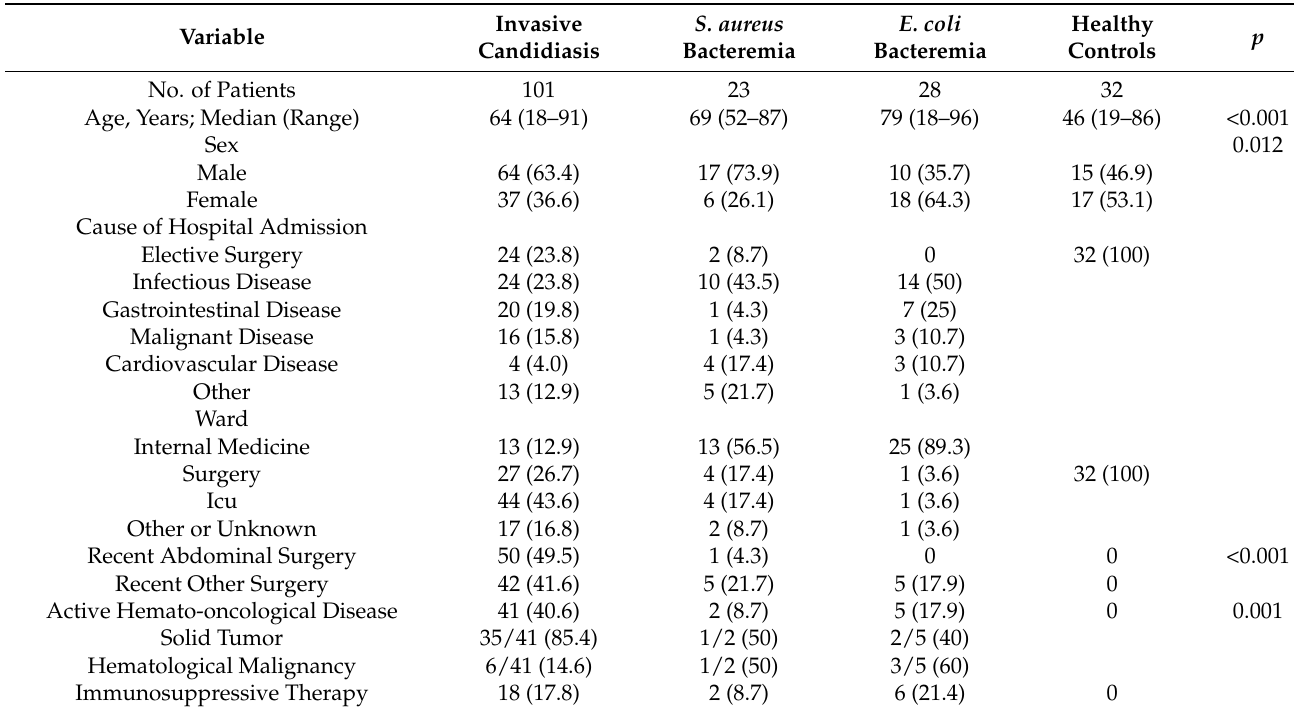
Table 1. Demographic data and baseline